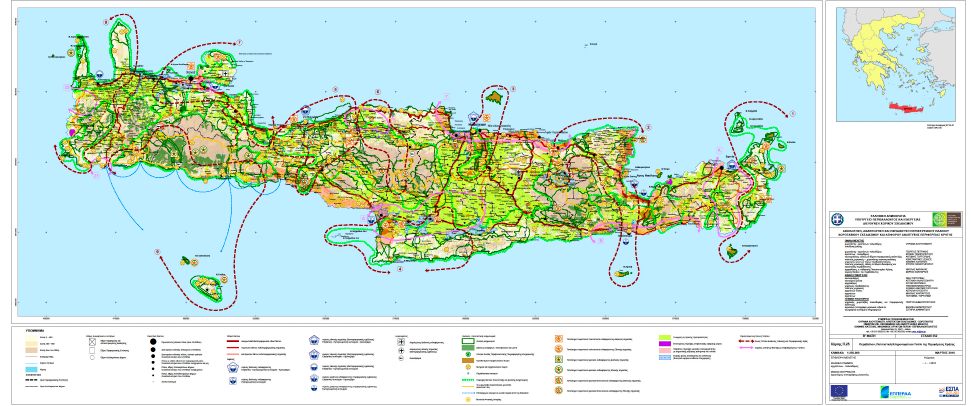
Figure 1. Landscape map of the Region of Crete.